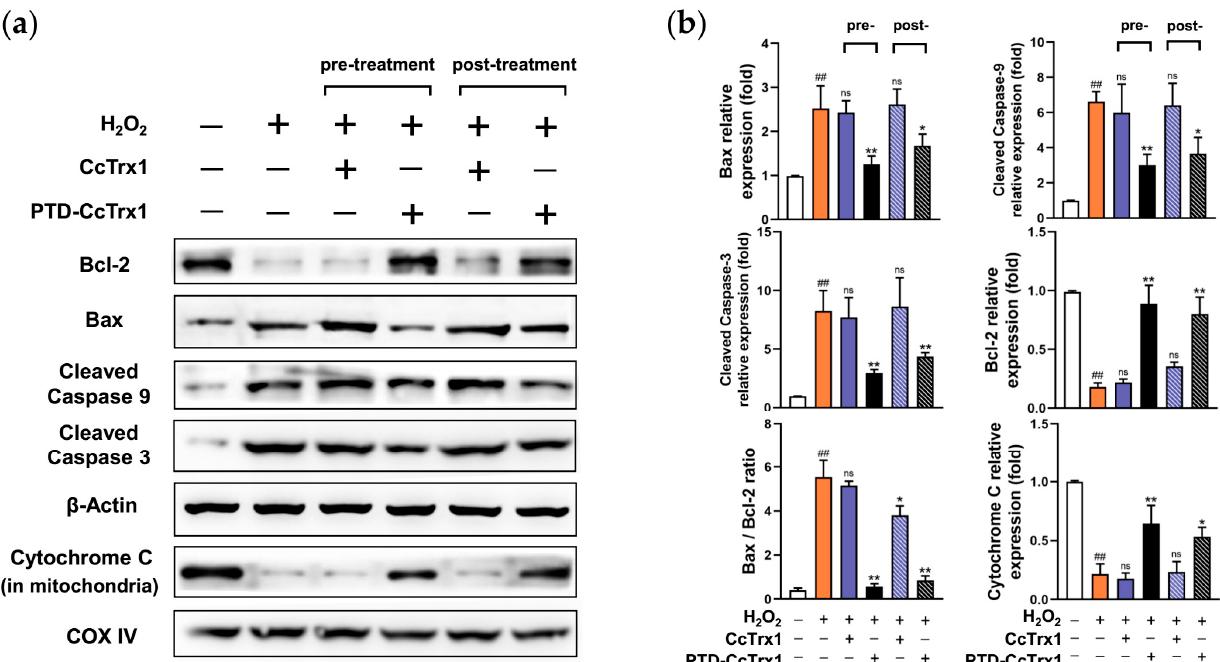
Figure 7. PTD-CcTrx1 inhibited the intrinsic apoptotic pathway in H 2 O 2 -treated HaCaT cells. First, HaCaT cells were treated with 10 μ M CcTrx1 and 10 μ M PTD-CcTrx1 before or after the exposure to 400 μ M H 2 O 2 . The cells were washed with ice-cold PBS, and cytoplasmic and mitochondrial proteins were extracted for the Western blot assay. ( a ) Western blot analysis of Bax, Bcl-2, cleaved-caspase 3, cleaved-caspase 9, and cytochrome c (in mitochondria) of each group. β -Actin and COX IV were set as internal references, respectively. ( b ) Relative contents of the proteins were calibrated by setting the control group as one. All treatments were performed in triplicate individually, and the data are presented as means ± SD ( n = 3) (## p < 0.01 vs. control; ns, no significance, * p < 0.05, ** p < 0.01 vs. H 2 O 2 alone group).